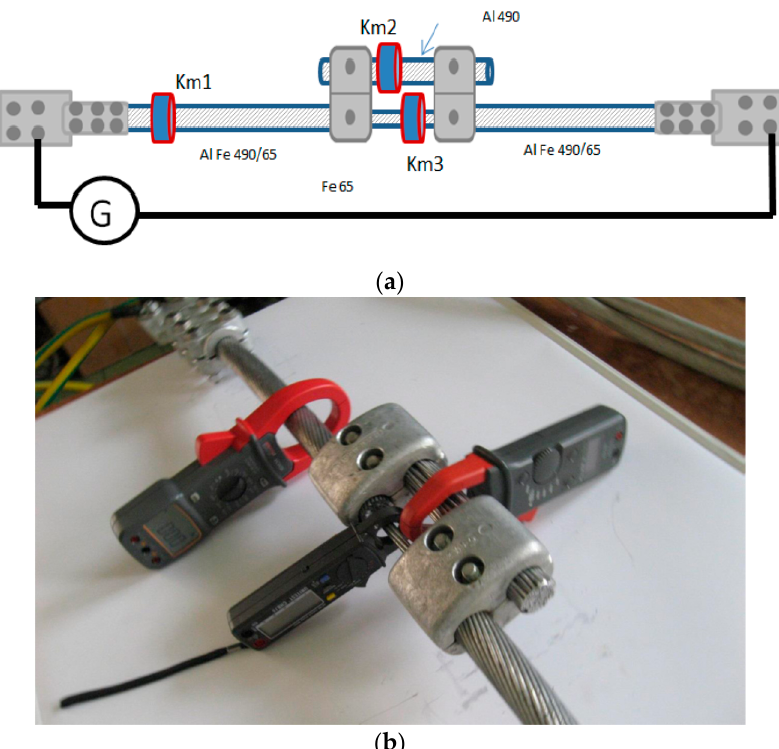
Table 2. Results of measurement with interrupted aluminum coat.